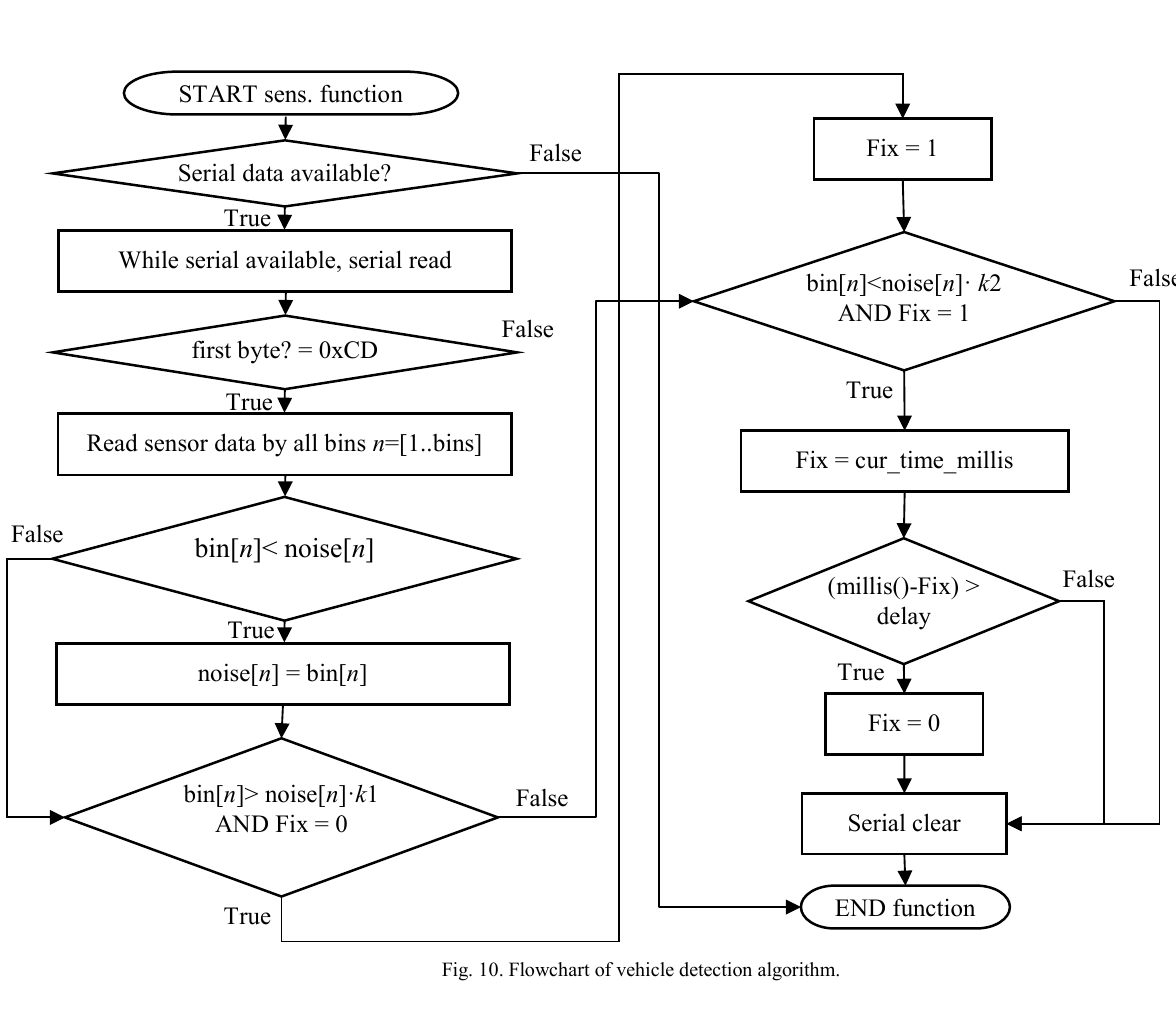
Fig. 10. Flowchart of vehicle detection algorithm.